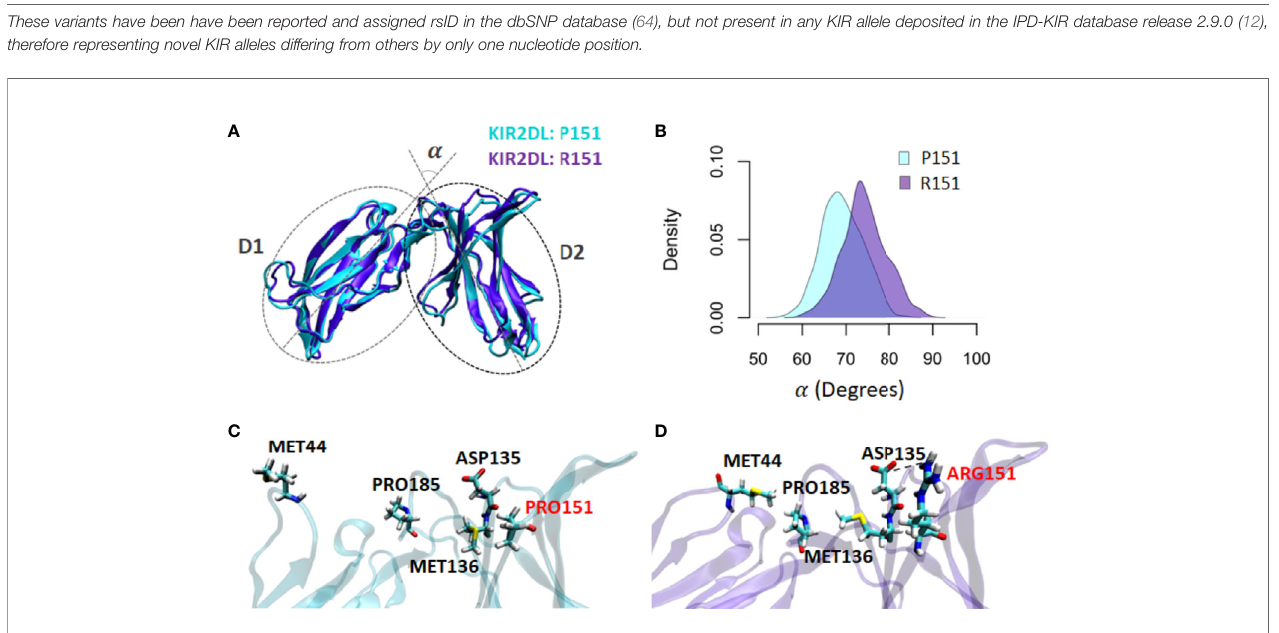
FIGURE 8 | Pro151Arg substitution in KIR2DL1 is predicted to affect the stability of its binding to HLA-C. The impact of the Pro151Arg mutation on the KIR2DL1 conformation and its HLA-C binding site was studied by simulating both the mutant and wildtype structures . (A) . The angle between D1 and D2 domains (alpha) of KIR2DL1 was computed in both allotypes as an indicator of conformational transition from the HLA-bound to a free state. (B) The alpha angle in the mutant is closer to the HLA-bound state, whereas the transition to the unbound state occurs smoothly in the wildtype. (C) The interaction between Met44 and Pro185 was disrupted upon angle change between D1 and D2 in the wildtype. (D) Arg151 forms an interaction with Asp135, which also leads to new interactions between Met136, Pro185, and Met44, maintaining the open conformation of the